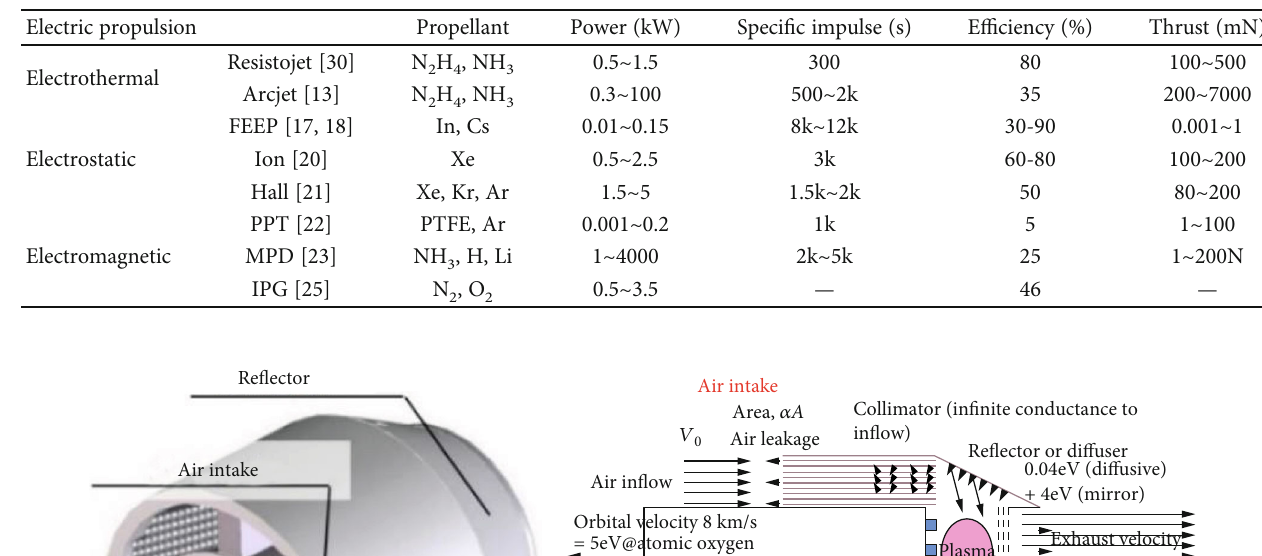
Table 2: Performance of electric propulsion systems [26] p.76.